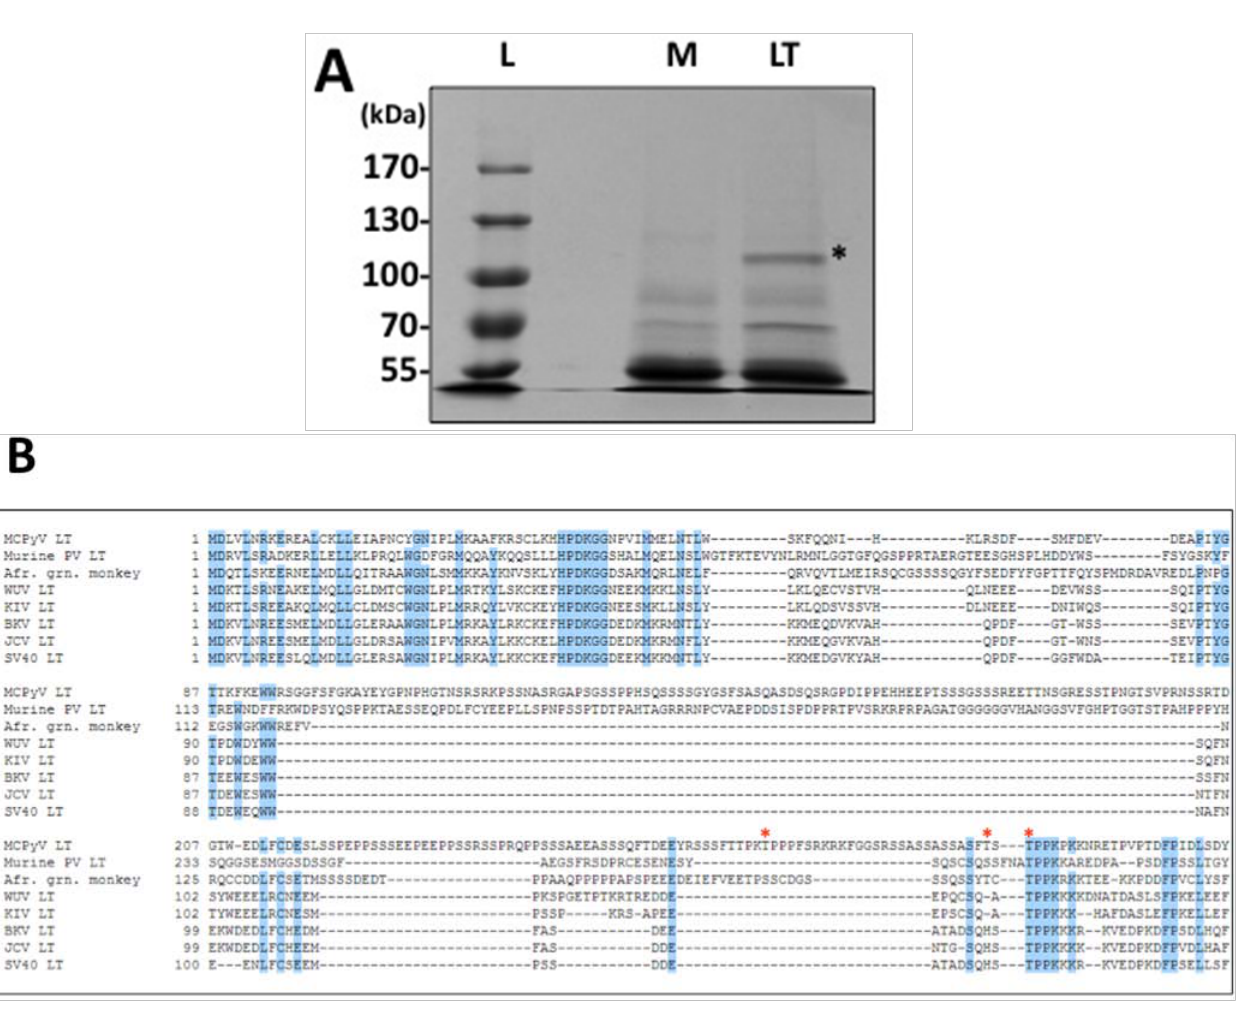
Figure 1. Identification of MCPyV LT phosphorylation sites. ( A ) Affinity-tagged MCPyV LT was transfected into HEK 293 cells. Forty-eight hours post transfection, lysates from transfected (LT) or untransfected (Mock, M) cells were purified with IgG-Sepharose beads. Bound proteins were cleaved from beads with TEV protease, separated by SDS-PAGE and stained with Coommassie brilliant blue. The band corresponding to MCPyV LT (*) was excised and analyzed by mass spectrometry. L—Protein Marker ladder; ( B ) Alignment of the N-terminal portion of various polyomavirus LT proteins. The three phosphorylated threonines identified by the proteomic analysis in (A) are indicated by the red asterisks (*). Conserved residues are highlighted in blue (80%